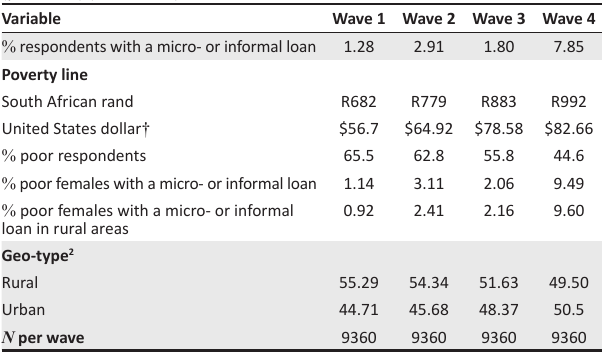
TABLE 1: Relevant demographic statistics expressed as a % of the sample (per wave) ( N = 37440).